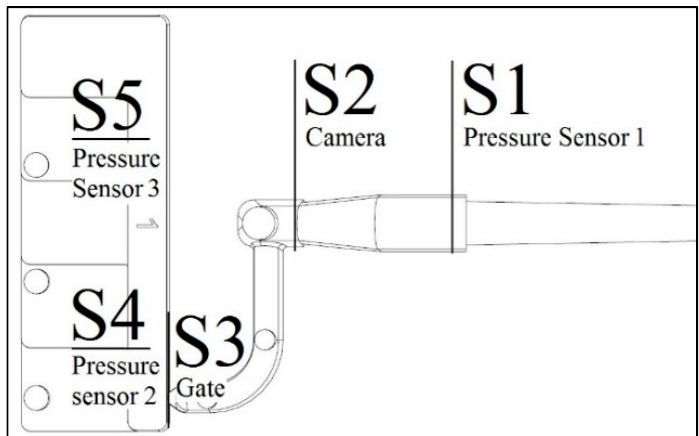
Figure 8. Positions of the sections used to compare experimental and simulated flow. S2 is the entrance in the field of view of the camera. S3 is the gate. S1, S4, and S5 are respectively the first, the second, and the third pressure sensors.